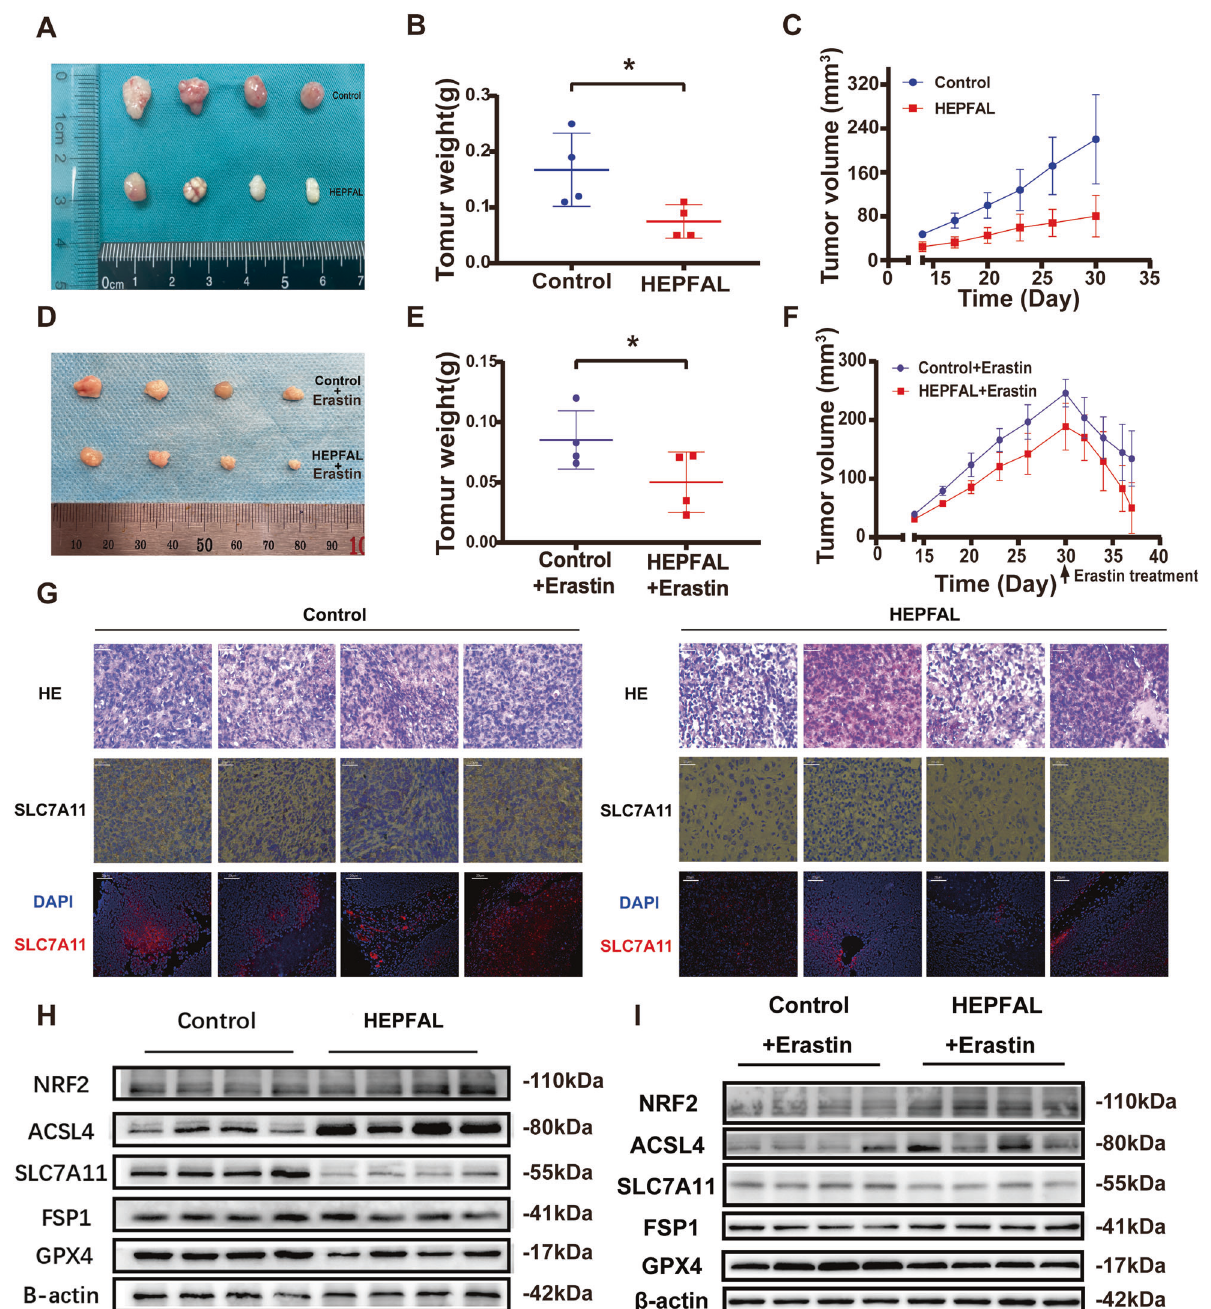
Fig. 7 Overexpression of lncRNA HEPFAL inhibits tumor growth of cell xenografts in nude mice. A 1 × 10 6 HCCLM3 cells were injected into nude mice and removed after 30 days. B Measure and count the weight of the tumor( n = 4). C The tumor volumes were measured every three days after the cells were injected for 14 days. D HCCLM3 cells were injected into nude mice and treated with erastin after 30 days. E Measure and count the weight of the tumor ( n = 4). F The tumor volumes were measured every three days after the cells were injected for 14 days. G SLC7A11 expression was detected by IHC and IF. H Western blot analysis of NRF2, ACSL4, SLC7A11, FSP1, and GPX4 protein level in tumor tissues. I Western blot analysis of NRF2, ACSL4, SLC7A11, FSP1, and GPX4 protein levels in tumor tissues after erastin treatment. * P <